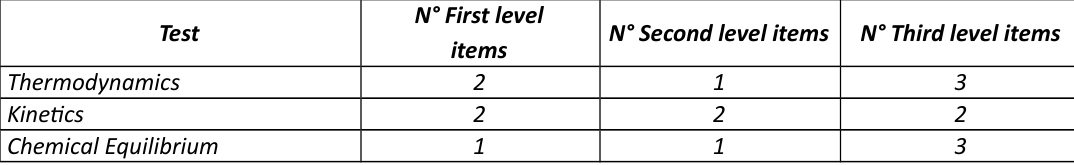
Table 2. Final structure of each